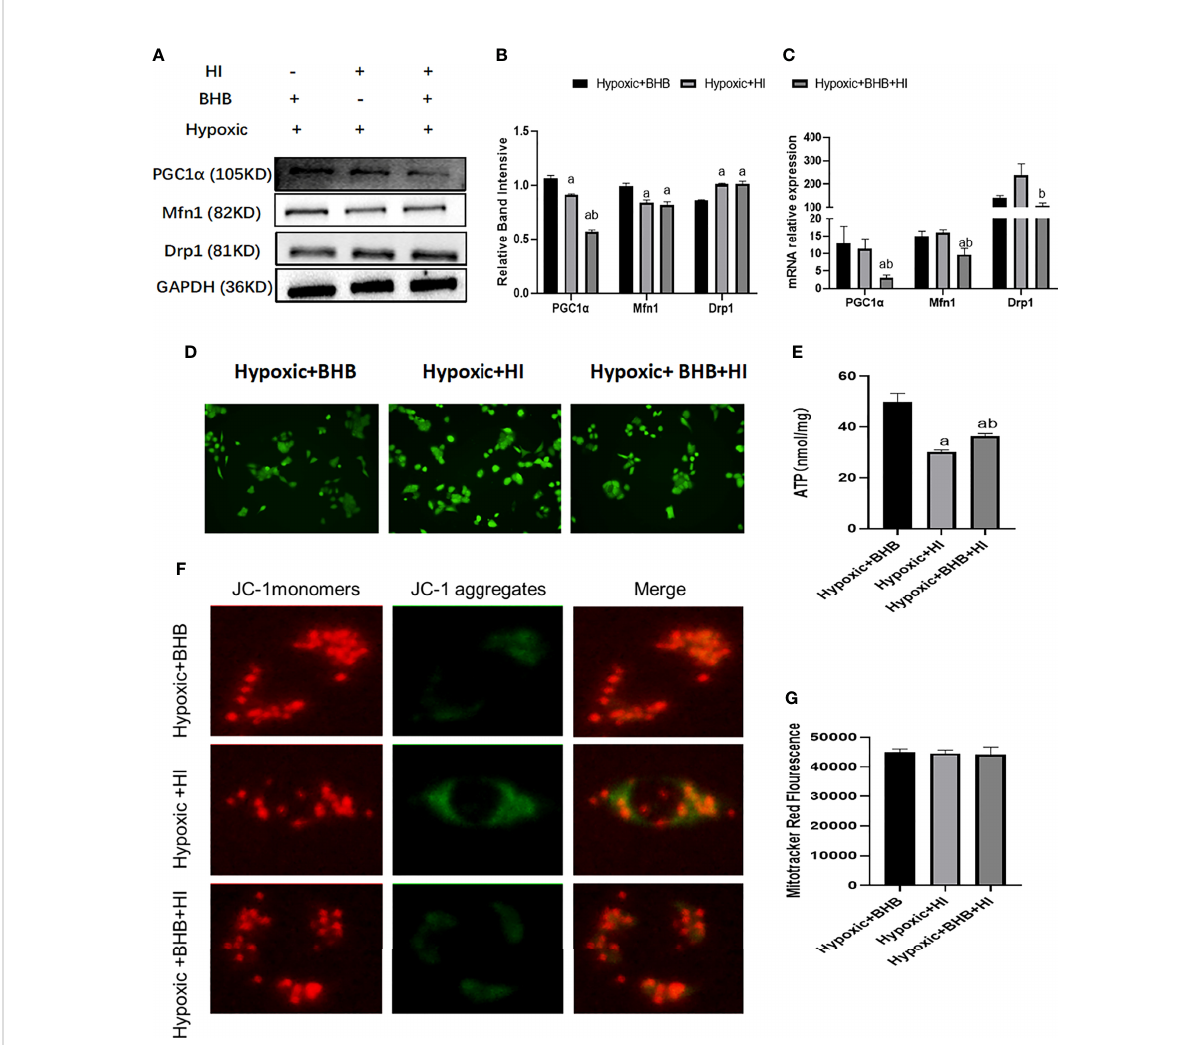
FIGURE 9 Effect of high insulin on BHB induced protection of mitochondrial in HK2 cells cultured in hypoxic environment. (A) Expression of PGC1 a , Mfn1, and Drp1; (B, C) Quantitative results of protein and gene expression of PGC1 a , Mfn1, and Drp1, respectively; (D – G) Changes of ROS, ATP production, mitochondrial membrane potential, and the mitochondrial number. a p < 0.05 compared with the Hypoxic + BHB group; b p < 0.05, compared with the Hypoxic + HI